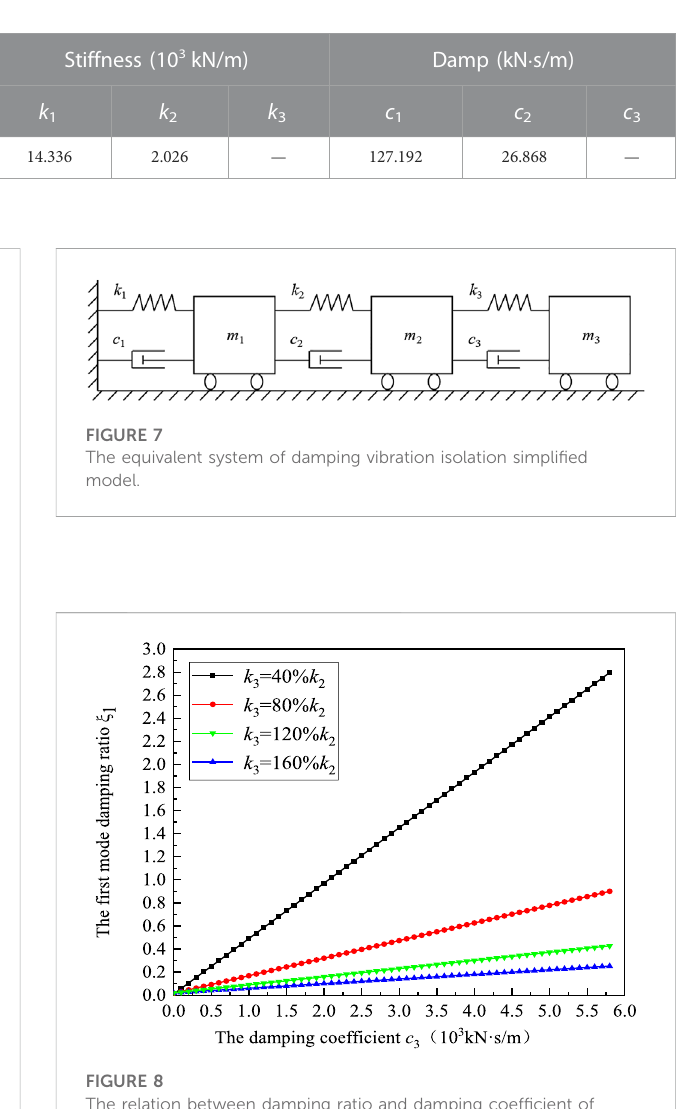
FIGURE 8 The relation between damping ratio and damping coef fi cient of vibration isolation